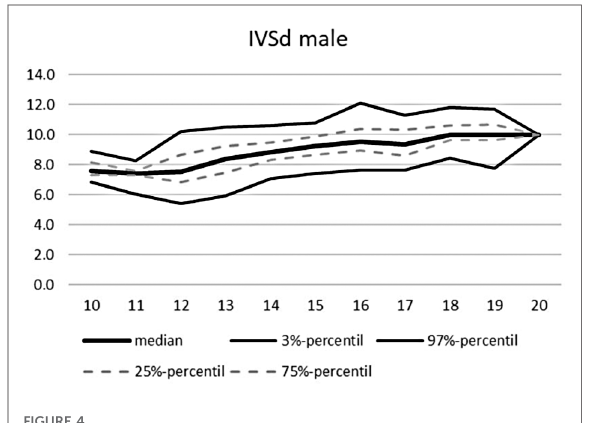
FIGURE 4 Echocardiographic values in dependence of age, IVSd male.